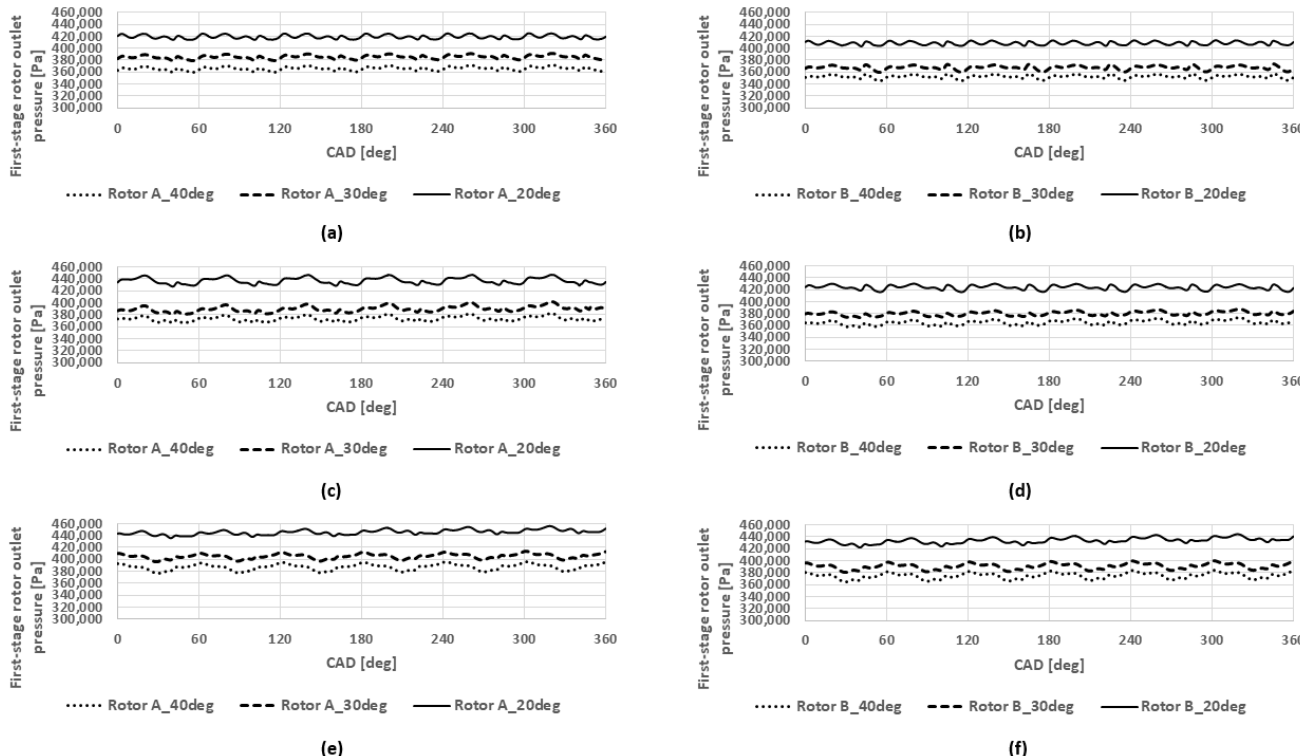
Figure 23. The plots of the area-averaged total pressure at the outlet from the first-stage rotor during the single revolution of the crankshaft for three different turbine speeds, VTG vane positions and rotor geometries: ( a ) rotor A at 60,000 rpm, ( b ) rotor B at 60,000 rpm, ( c ) rotor A at 50,000 rpm, ( d ) rotor B at 50,000 rpm, ( e ) rotor A at 40,000 rpm, ( f ) rotor B at 40,000 rpm.